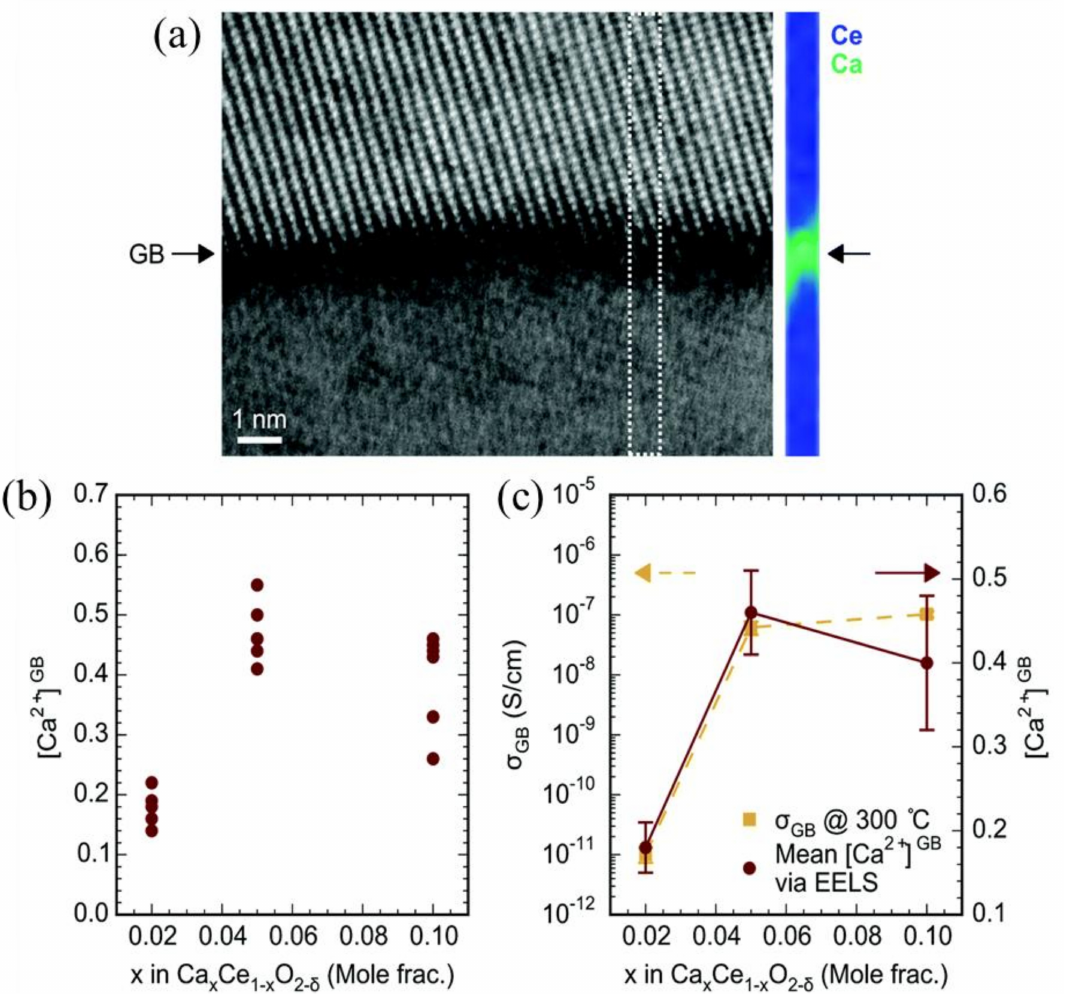
Figure 34. ( a ) ADF AC-STEM image of a GB in 5CCO, the associated elemental EELS map was acquired from the area in the dashed box and is on the right. ( b ) All EELS measurements of GB Ca 2+ concentration, ( c ) Influence of nominal Ca 2+ concentration, x, on GB conductivity measured at 300 ◦ C [21]. Reprinted from Nanoscale, Enhanced ionic conductivity in electroceramics by nanoscale enrichment of grain boundaries with high solute concentration, William J. Bowman, Madeleine N. Kelly, Gregory S. Rohrer, Cruz A. Hernandez and Peter A. Crozier, 2017, 9, 17293–17302, with permission from the Royal Society of Chemistry